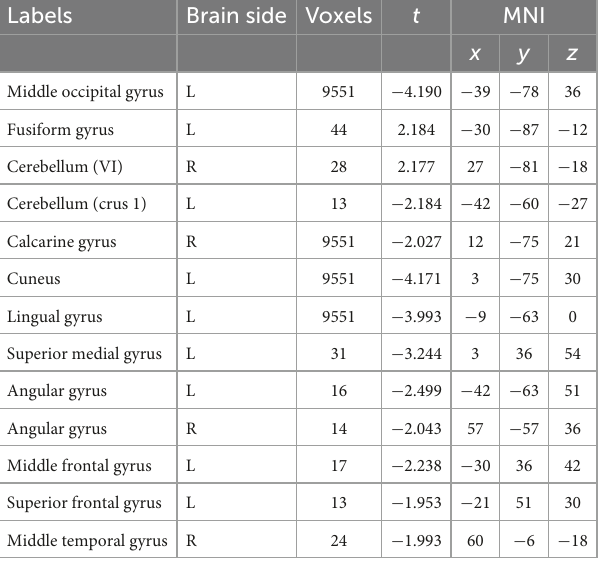
TABLE 3 Clusters of brain areas activated by angular shapes.